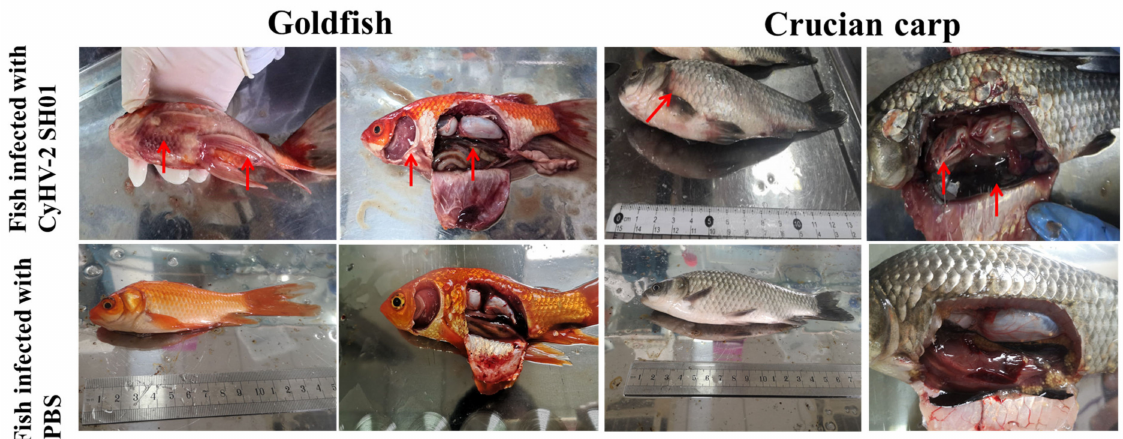
Figure 4. Gross pathology of CyHV-2 in infected goldfish and crucian carp. Goldfish infected by intraperitoneal injection: dorsal and caudal fins bleeding from the base, and liver and spleen enlargement. Crucian carp infected by intraperitoneal injection: gill bleeding, massive abdominal hemorrhage, abdominal swelling and congestion, eyeball protrusion. Red arrows show the representative symptoms of CyHV-2 infection in experimental